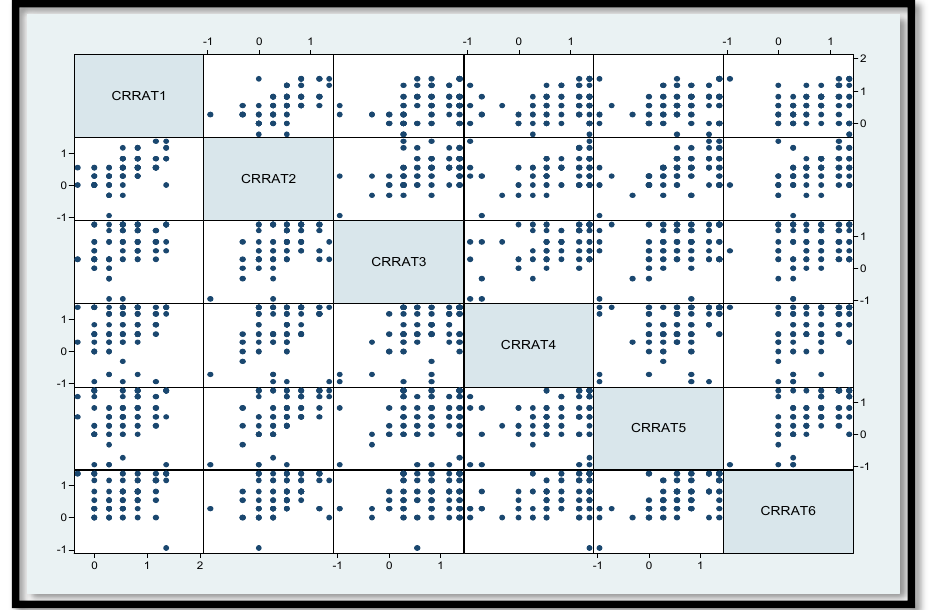
Figure A2. The scatter plot matrix of the mid-point CRRA exhibited by the subjects.